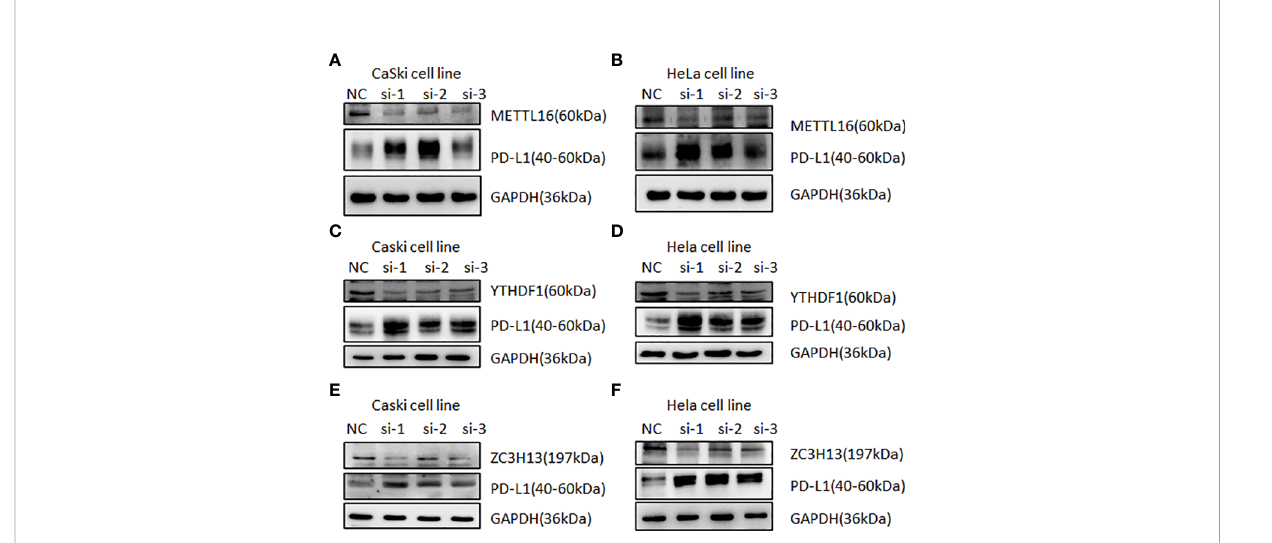
FIGURE 12 Western blotting was used to detect the relationship between m6A regulators and PD-L1 in cervical cancer. Immunoblot of METTL16, YTHDF1, ZC3H13, and PD-L1 in CaSki cells and HeLa cells after depletion of METTL16 (A, B) , YTHDF1 (C, D) , and ZC3H13 (E, F) . GAPDH was used as a loading control.